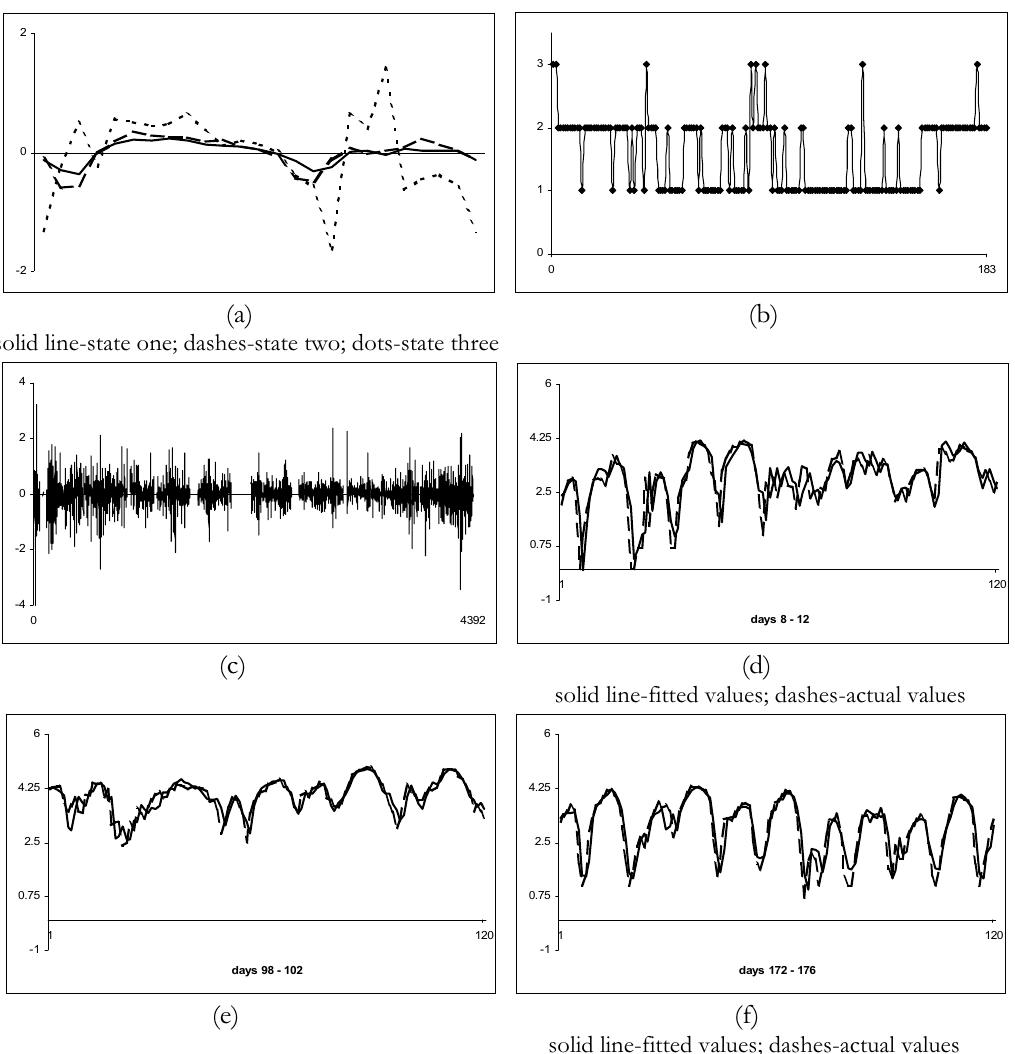
Figure 3 – The daily component from 5 a.m. to 5 a.m. (a); the sequence of the hidden states (b); the sequence of the residuals (c); actual and fitted values of the sub-series of days 8 - 12 (d), 98 - 102 (e), 172 - 176